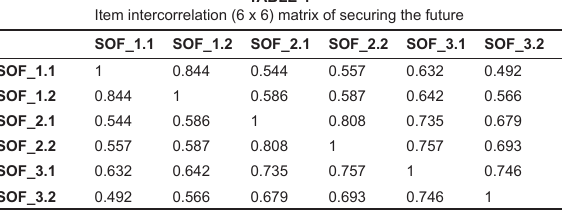
TABLE 4 Item intercorrelation (6 x 6) matrix of securing the future